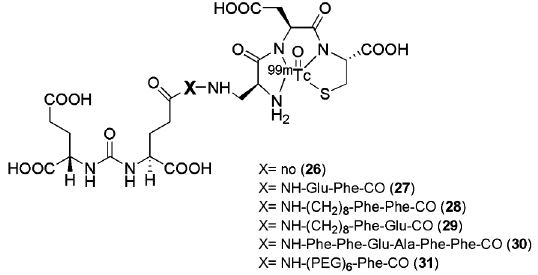
Figure 7. 99m Tc-labeled PSMA inhibitors ( 26 – 31 ) [100].